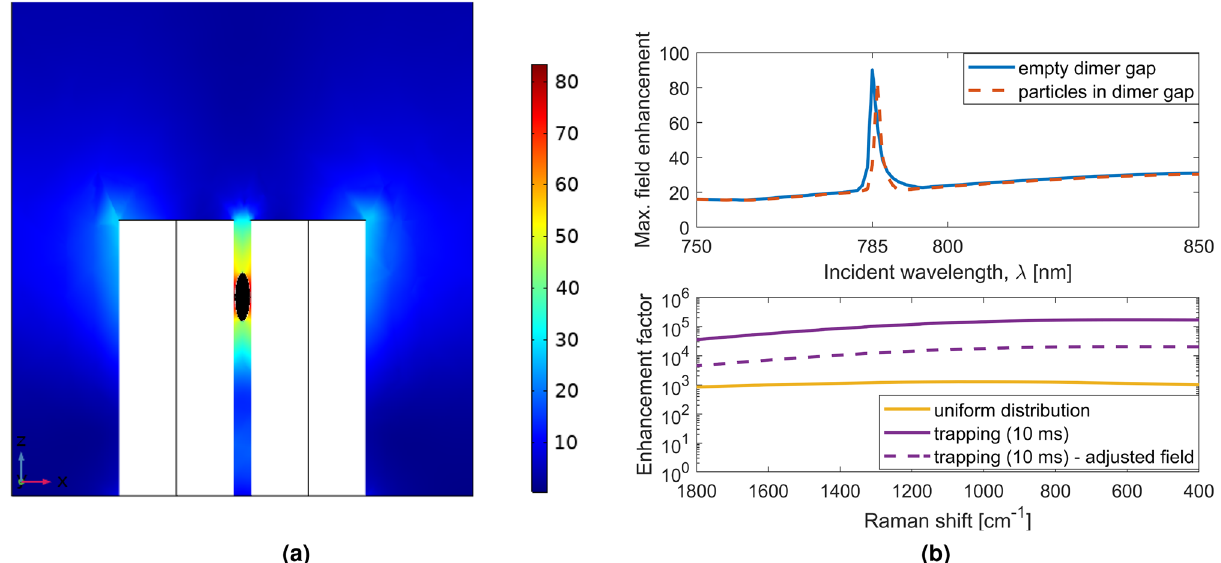
Figure 6. ( a ) Scattered electric field magnitude (incident wavelength 785 nm) showing a polystyrene ellipsoid (black) at the point of highest field magnitude 16 . The ellipsoid was chosen to simulate the presence of a few particles trapped within the dimer. In ( b ) the effect of including the polystyrene ellipsoid is shown: (top) the resulting maximum local field enhancement within the unit cell of the metasurface; (bottom) the SERS enhancement factor (source: 20 mW μm -2 , 785